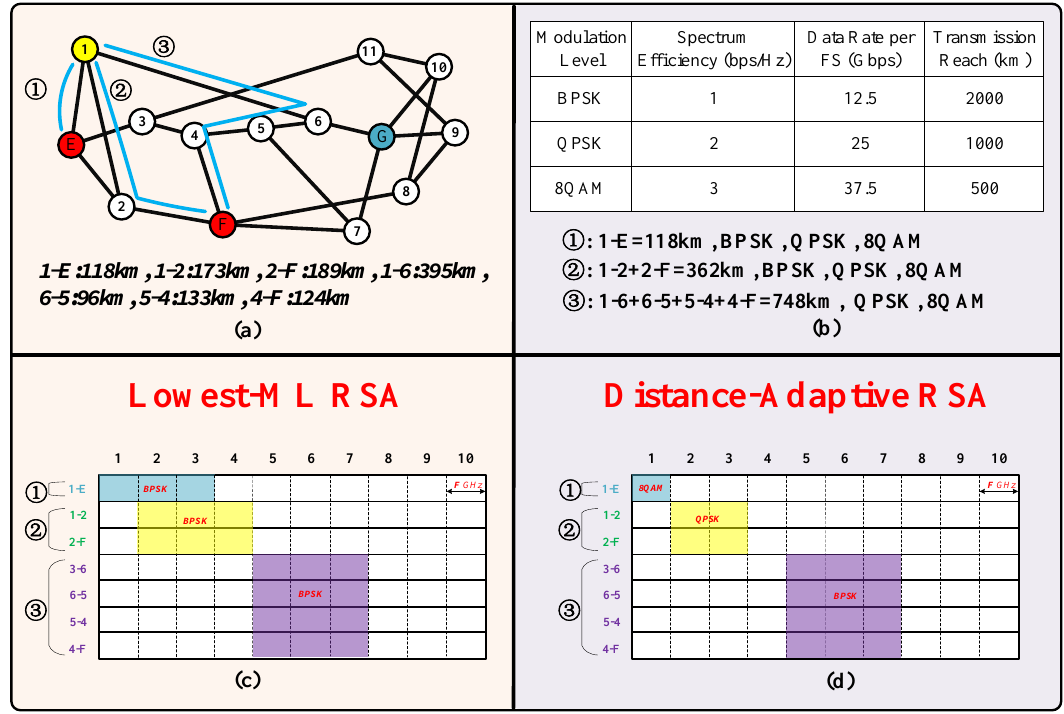
Figure 9. The RSA for end-to-sensing paths: ( a ) end-to-sensing paths; ( b ) the transmission distance and capacity of each kind of modulation level; ( c ) the lowest modulation level allocation; ( d ) the distance-adaptive modulation level allocation.